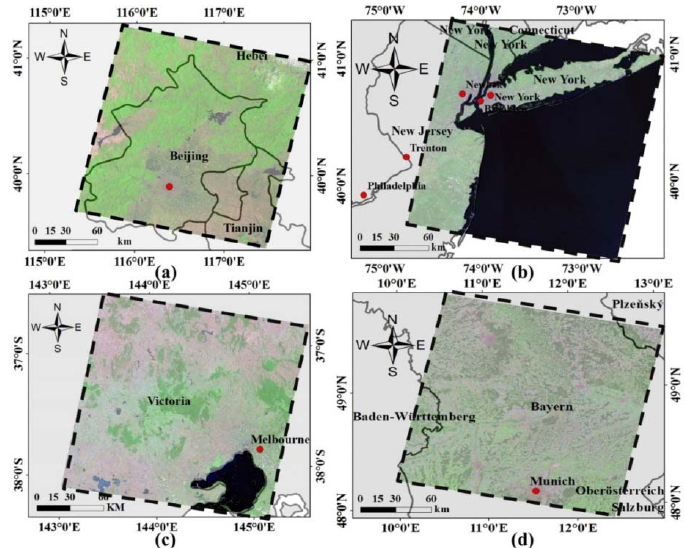
Figure 1. Study areas in RGB-5, 4, 3 include: ( a ) Beijing-123/32 (path/row), China; ( b ) New York-130/322, United States of America; ( c ) Melbourne-93/86, Australia; and ( d ) Munich-193/26, Germany. The dotted line represents the scene extent in each study area, and the box represents the normal Worldwide Reference System ( WRS-2) boundary.